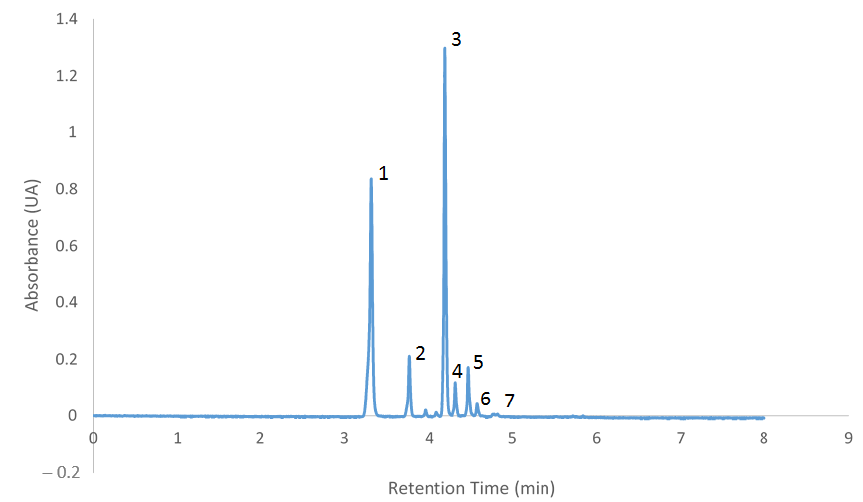
Figure 1. Chromatogram of the betacyanins detected in the red dragon fruit extract samples (λ = 538